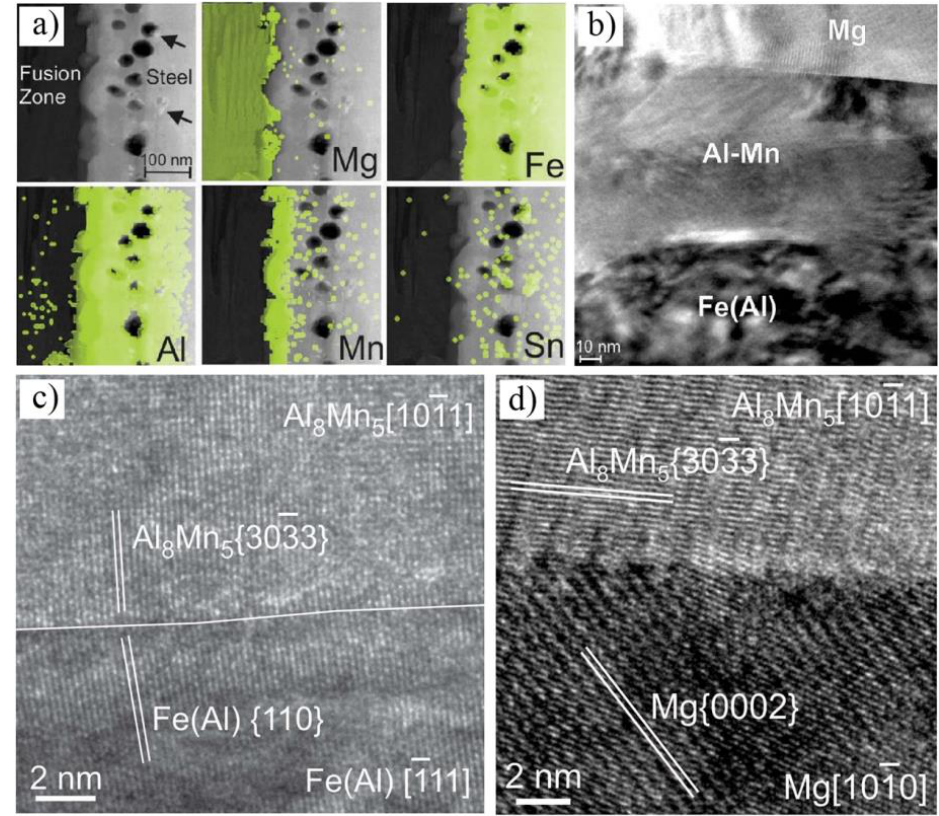
Figure 13. Laser welding of Mg/steel with Sn interlayer [45] ( a ) STEM-EDS concentration maps; ( b ) bright field TEM image of the Fe(Al)/Al 8 Mn 5 /Mg interfaces; ( c , d ) HR-TEM image of Fe(Al)/Al 8 Mn 5 and Al 8 Mn 5 /Mg interface.